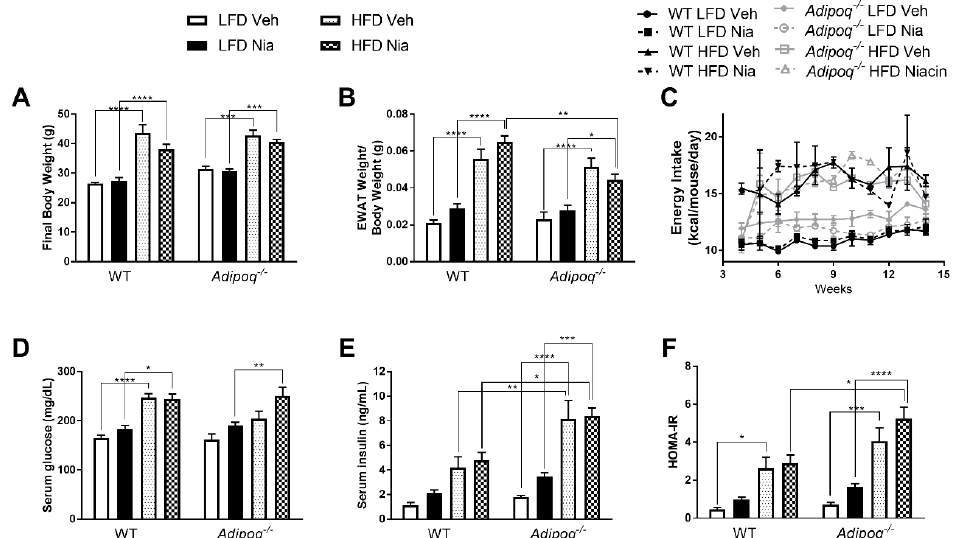
Figure 1. E ff ects of high-fat diet (HFD) and niacin on metabolic parameters. E ff ects of HFD and niacin on body weight ( A ), EWAT weight ( B ), energy intake ( C ), serum glucose concentrations ( D ), serum insulin concentrations ( E ), and HOMA-IR ( F ) in WT and Adipoq - / - mice. Data are presented as mean + SEM. * p ≤ 0.05; ** p ≤ 0.01; *** p ≤ 0.001; **** p ≤ 0.0001; WT low-fat diet (LFD) Veh, n = 8; WT LFD Nia, n = 8; WT HFD Veh, n = 8; WT HFD Nia, n = 7; Adipoq - / - LFD Veh, n = 6; Adipoq - / - LFD Nia, n = 7; Adipoq - / - HFD Veh, n = 8; Adipoq - / - HFD Nia, n =